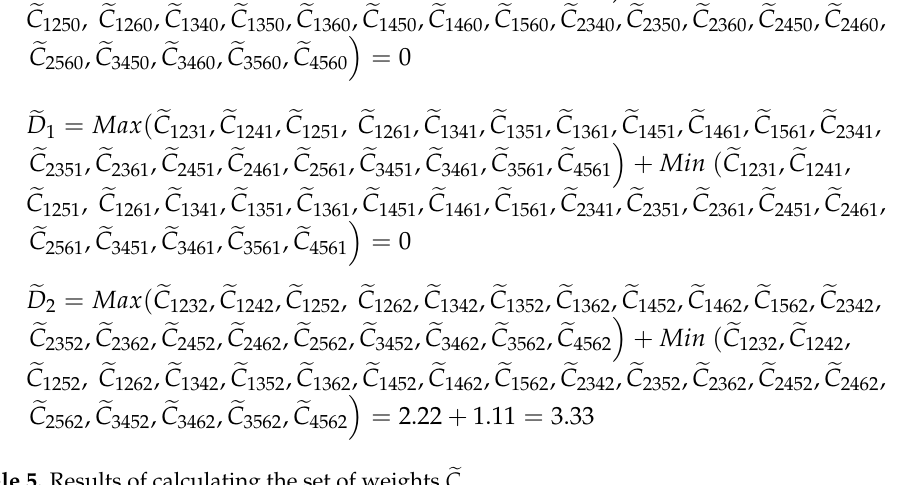
Table 5. Results of calculating the set of weights (cid:101) C